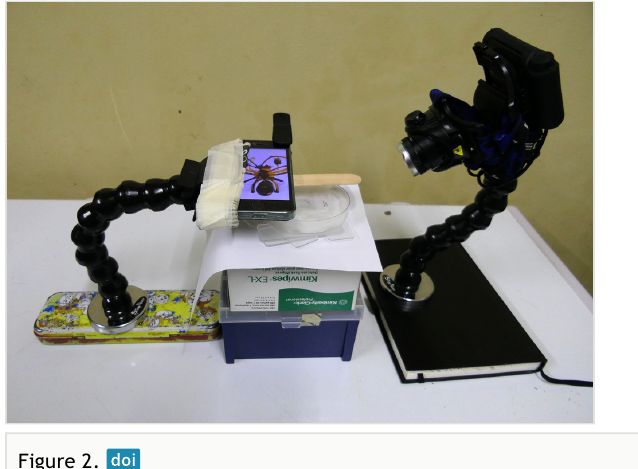
Figure 2. Improvised specimen imaging station at Danau Girang Field